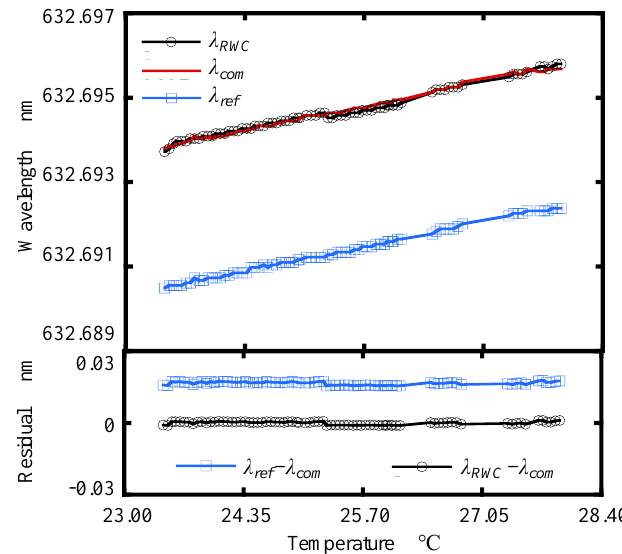
Figure 7. Calibration result of the RWC under various temperatures.